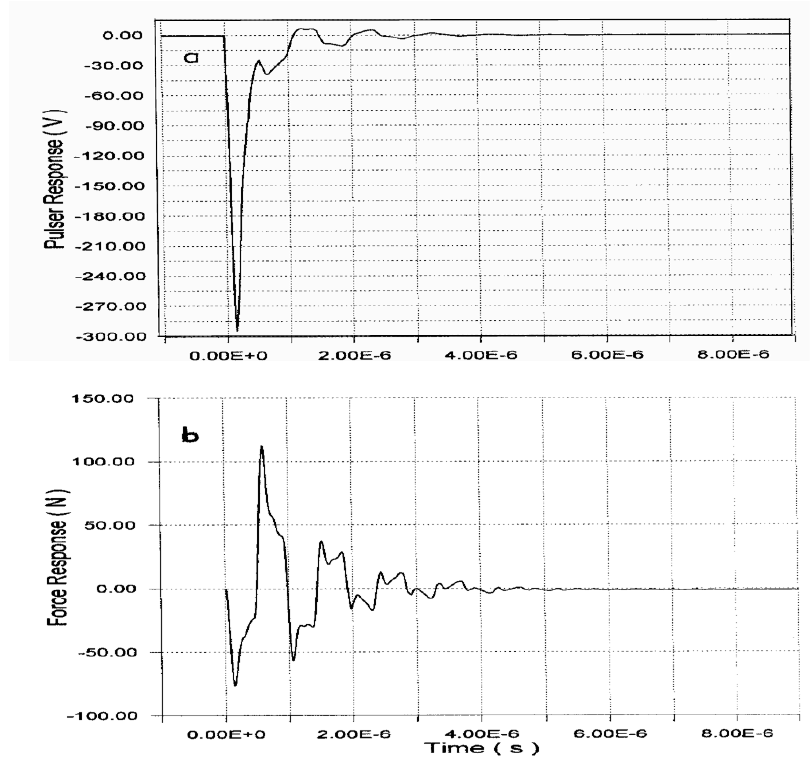
Figure 9. ( a ) Computer simulation of the HV driver spike related to the measured HV waveform of Figure 8, also showing the motional effects from the driven transducer, superimposed on the spike. ( b ) Calculated transient motional force over the transducer radiating face, originating those effects.